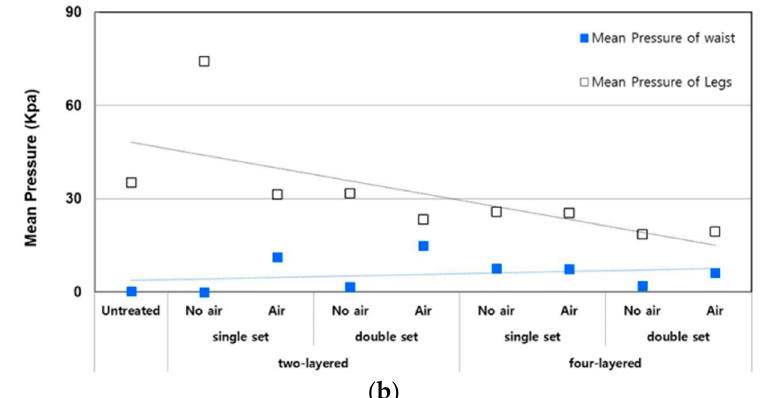
Figure 13. Relationship between the contact area and pressure on the leg and waist of ( a ) two-layered and ( b ) four-layered harnesses.